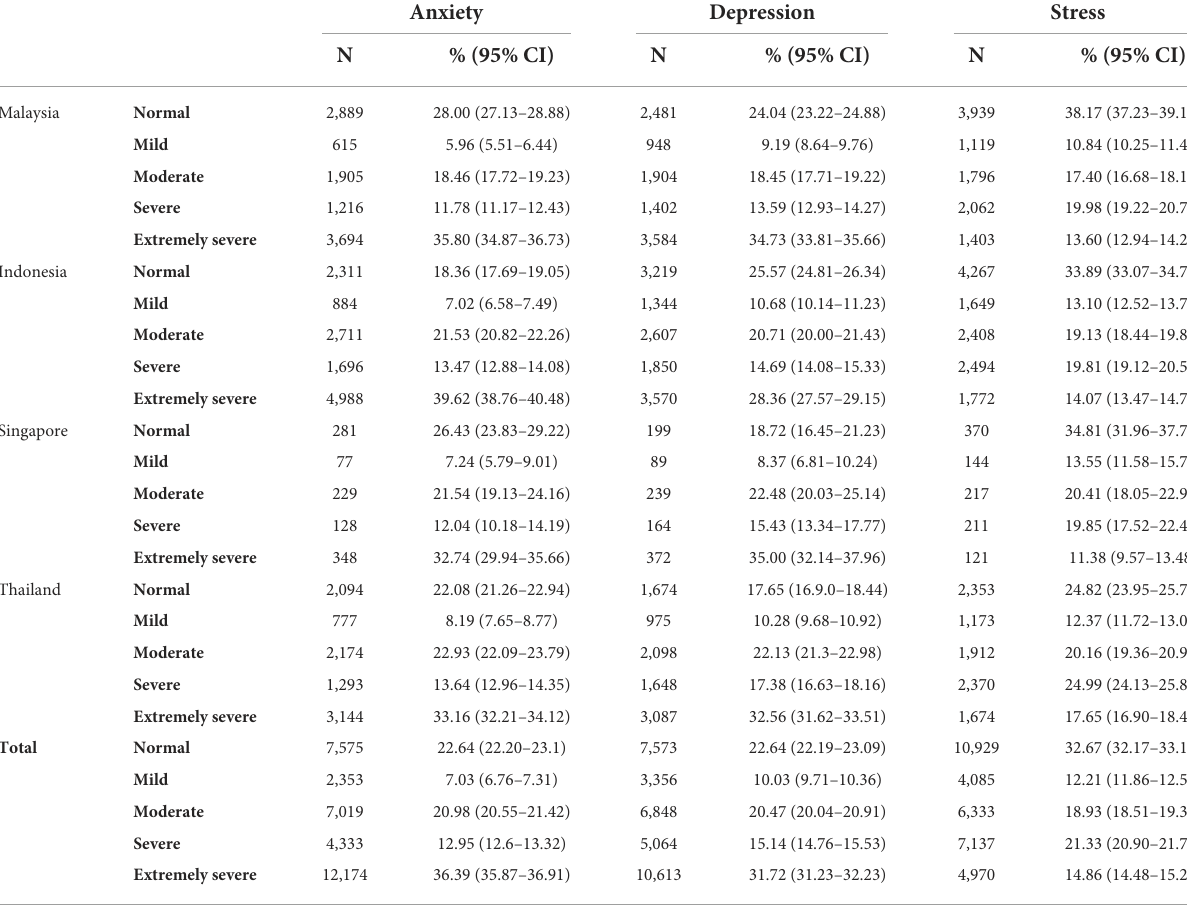
TABLE 2 Prevalence of depression, anxiety, and stress symptoms at each level of symptom severity in each country and across the sample. Anxiety Depression